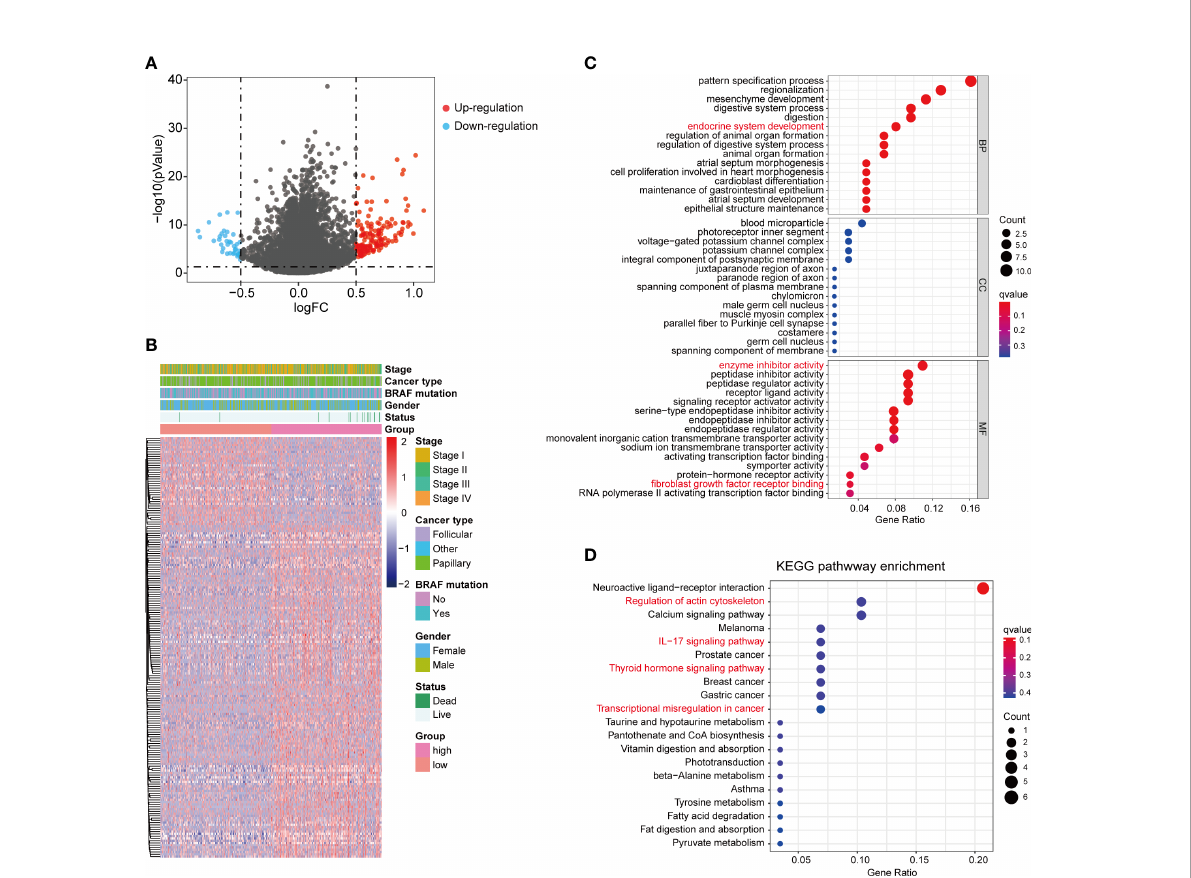
FIGURE 5 DEGs between high and low fi brosis score patients. (A) The volcano plot of DEGs between high and low fi brosis score patients. (B) The expression heatmap of DEGs and clinical features in thyroid cancer patients. (C) GO enrichment of DEGs. (D) KEGG enrichment of DEGs.